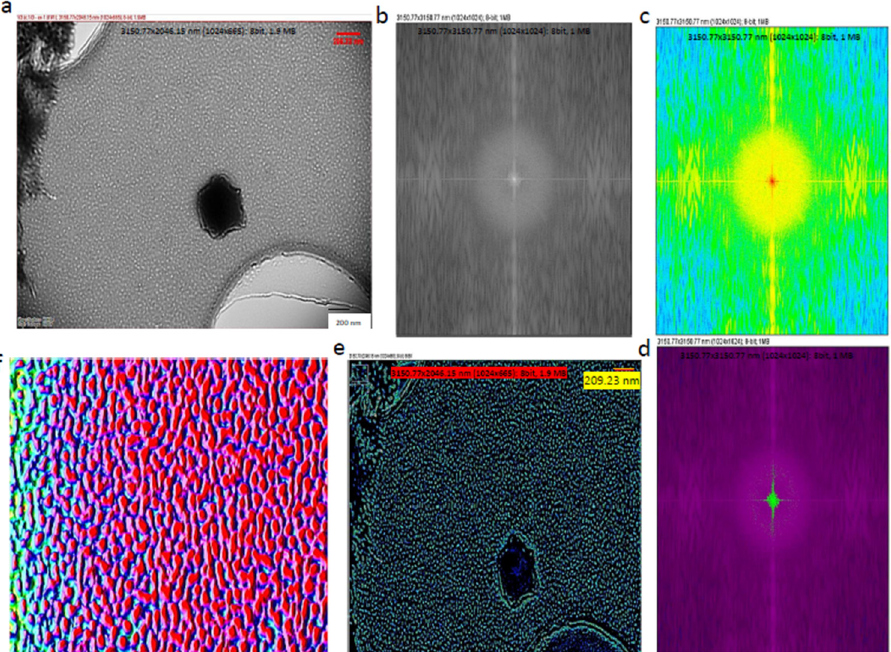
Figure 4. Cryo-TEM image analysis. ( a ) Cryo-TEM images of the IDC-derived exosomes; ( b ) Fourier transform image of IDC-derived exosomes; ( c ) identification of lower and similar frequencies; ( d ) identification of lowest and most prominent frequencies; ( e ) identification of specific properties of exosome components; ( f ) image converted to 3D image to identify exosomes as particles. During the conversion from 2D to 3D, all images had the same number of pixels (1024 × 1024). When the lowest ‐ frequency regions were analyzed (Figure 5a), exosomes of similar dimensions were regularly distributed ~5 nm on the TEM grid (Figure 5b,c). However, confocal images showed that large particles were displayed in different shapes and sizes in the micron region within EVs (see supplementary data Video S2).